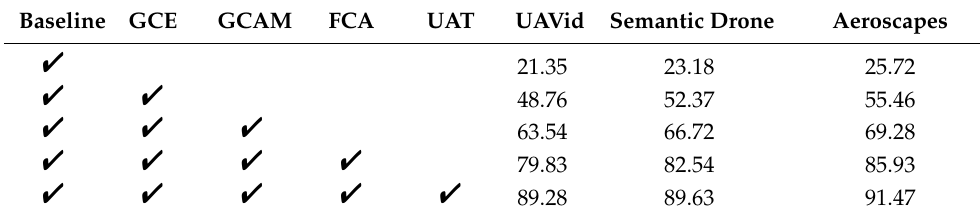
Table 7. Performance of each component in GFANet for different datasets (reported in PA). Baseline